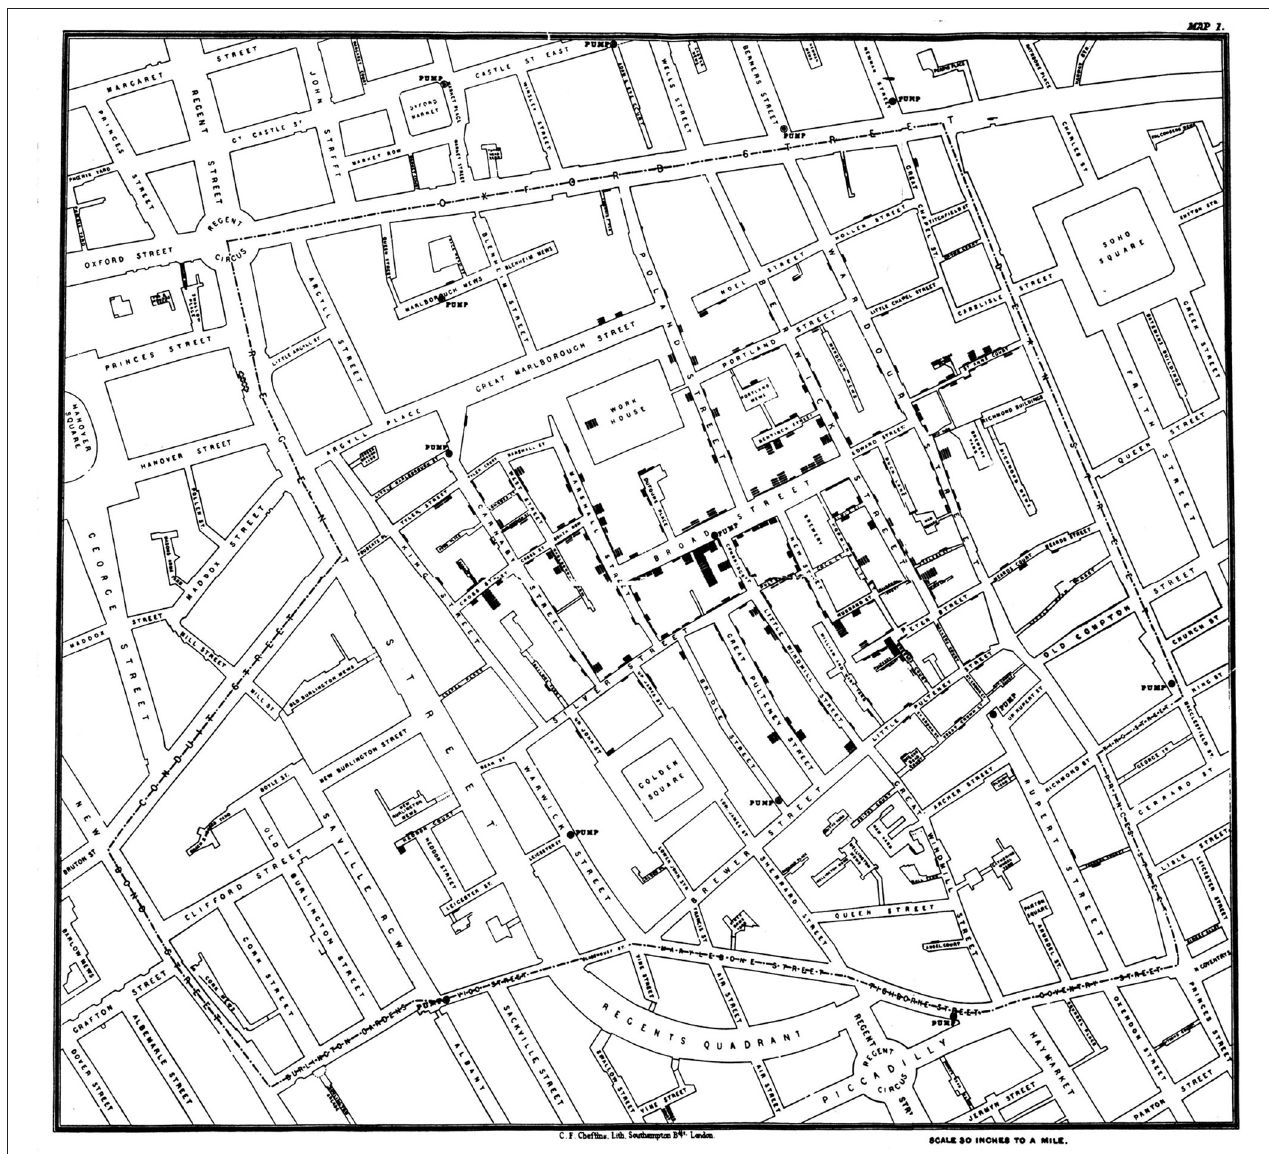
FIGURE 2 | “There were many persons who drank the water from Broad Street pump about the time of the outbreak, without being attacked with cholera; but this does not diminish the evidence respecting the influence of the water…The deaths which occurred during this fatal outbreak of cholera are indicated in the accompanying map” [(26), p. 45]. Source: